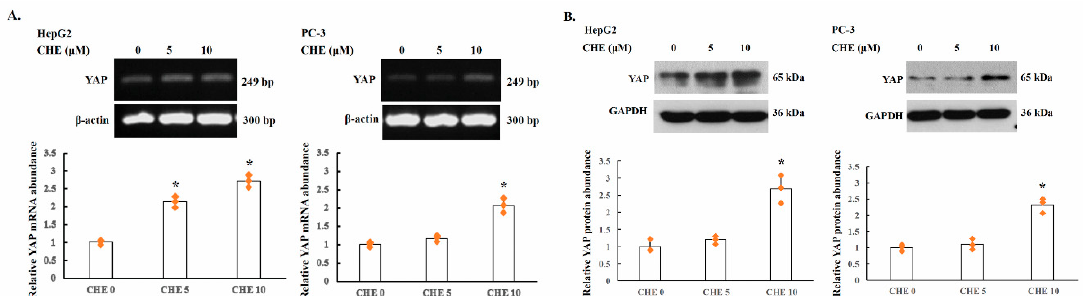
Figure 2. YAP expression is enhanced by PKC inhibitor in HepG2 cells and PC-3 cells. (( A ). top). Cells were treated with PKC inhibitor chelerythrine chloride at the indicated concentrations for 24 h and the expression of YAP and β -actin transcripts was assessed by semi-quantitative RT-PCR assay as described in the Materials and Methods ( n = 3). Amplified PCR products were resolved on a 1% agarose gel. (( A ). bottom) Quantitative real-time PCR was used to quantify the expression levels of YAP. Values were normalized using β 2-microglobulin mRNA. ( B ). For Western blot analysis, cells were incubated with chelerythrine chloride at the indicated concentrations. Cell lysates were prepared 24 h after treatment, and were subjected to Western blot analysis with anti-YAP, and anti-GAPDH antibodies ( n = 3). Significance was tested using one-way analysis of variance (ANOVA) with Holm–Sidak method post hoc test, where * p < 0.05 compared to the